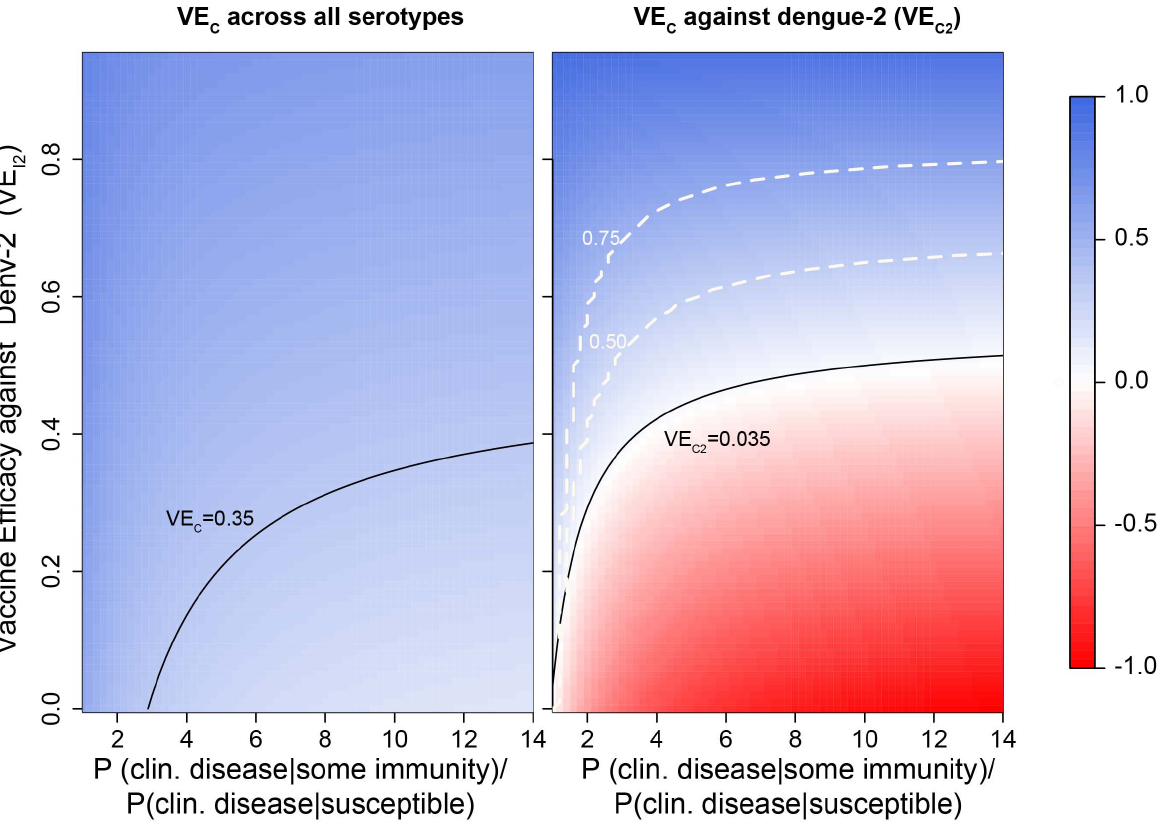
Figure 2. Output from our analytical framework showing the relationship between VE I and VE C . For this example, we assumed the following serotype-specific efficacies against infection: VE I1 =0.6 (i.e., VE I for DENV1=0.6), VE I3 =0.8, and VE I4 =0.9. We explored a range of VE I against dengue-2 (VE I2 ) (y-axis). The x-axis is the ratio of the probabilities of developing clinical disease in people with and without prior immunity, and hence reflects the extent to which prior heterologous immunity (natural or vaccine acquired) modifies the probability of clinical disease. The background color represents expected vaccine efficacy against clinically apparent infection for all serotypes (left panel) and for dengue-2 (right panel). Solid black contours indicate the clinical vaccine efficacy VE C observed in the Ratchaburi trial [1] according to the intention-to-treat analysis. Dashed white contours indicate levels of the ratio VE C2 :VE I2 . Thus, the 0.5 contour divides the regions where VE C2 underestimates VE I2 by a factor greater (above) or lower (below) than 0.5. In this particular simulation, VE C always underestimates VE I